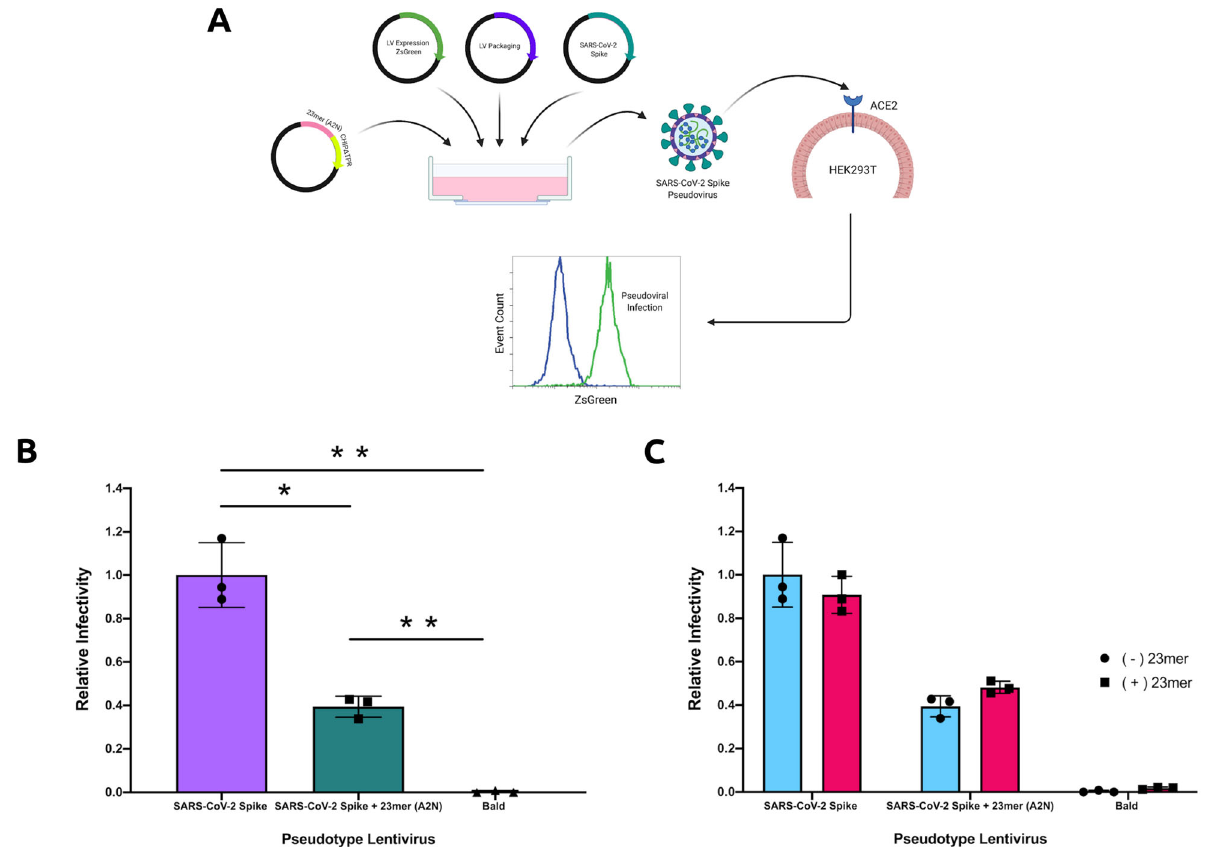
Fig. 4 Inhibition of infection-competent viral production. a Schematic demonstrating repurposed pseudoviral infection assay. Pseudotyped lentivirus is produced with a ZsGreen expression plasmid, lentivirus packaging plasmid, and an envelope protein plasmid encoding the S protein, in the presence of the (A2N)-CHIP Δ TPR fusion plasmid. After viral supernatant recovery, hACE2 expressing HEK293T cells are infected, and infection rate is calculated as the percentage of ZsGreen + cells by fl ow cyometry. b Analysis of pseudoviral infection inhibition by fl ow cytometry. All samples were performed in independent transduction triplicates ( n = 3) and gated on ZsGreen + fl uorescence. Relative infectivity ratios were calculated by normalizing ZsGreen + fl uorescence percentages to the SARS-CoV-2 Spike (induced ACE2) positive control. Standard deviation was used to calculate error bars. Statistical analysis was performed using the two-tailed Student ’ s t test, using the GraphPad software package. Calculated P values are represented as follows: * P ≤ 0.05, ** P ≤ 0.01. c Analysis of pseudoviral infection inhibition with or without exogenous addition of peptide by fl ow cytometry. All samples were performed in transduction triplicates ( n = 3) and gated on ZsGreen + fl uorescence. Relative infectivity ratios were calculated by normalizing ZsGreen + fl uorescence percentages to the SARS-CoV-2 Spike (induced ACE2) positive control. Standard deviation was used to calculate error